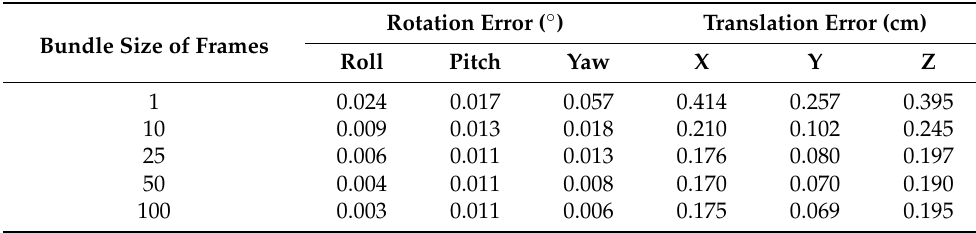
Table 8. Comparison of calibration performance according to the bundle size of frames for temporal filtering on the KITTI dataset.